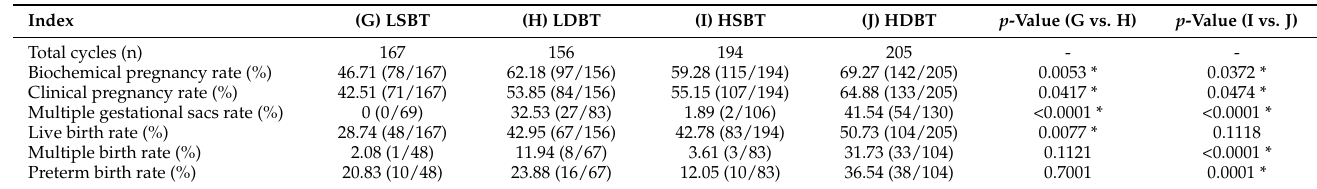
Table 5. Cycle outcomes of the four study